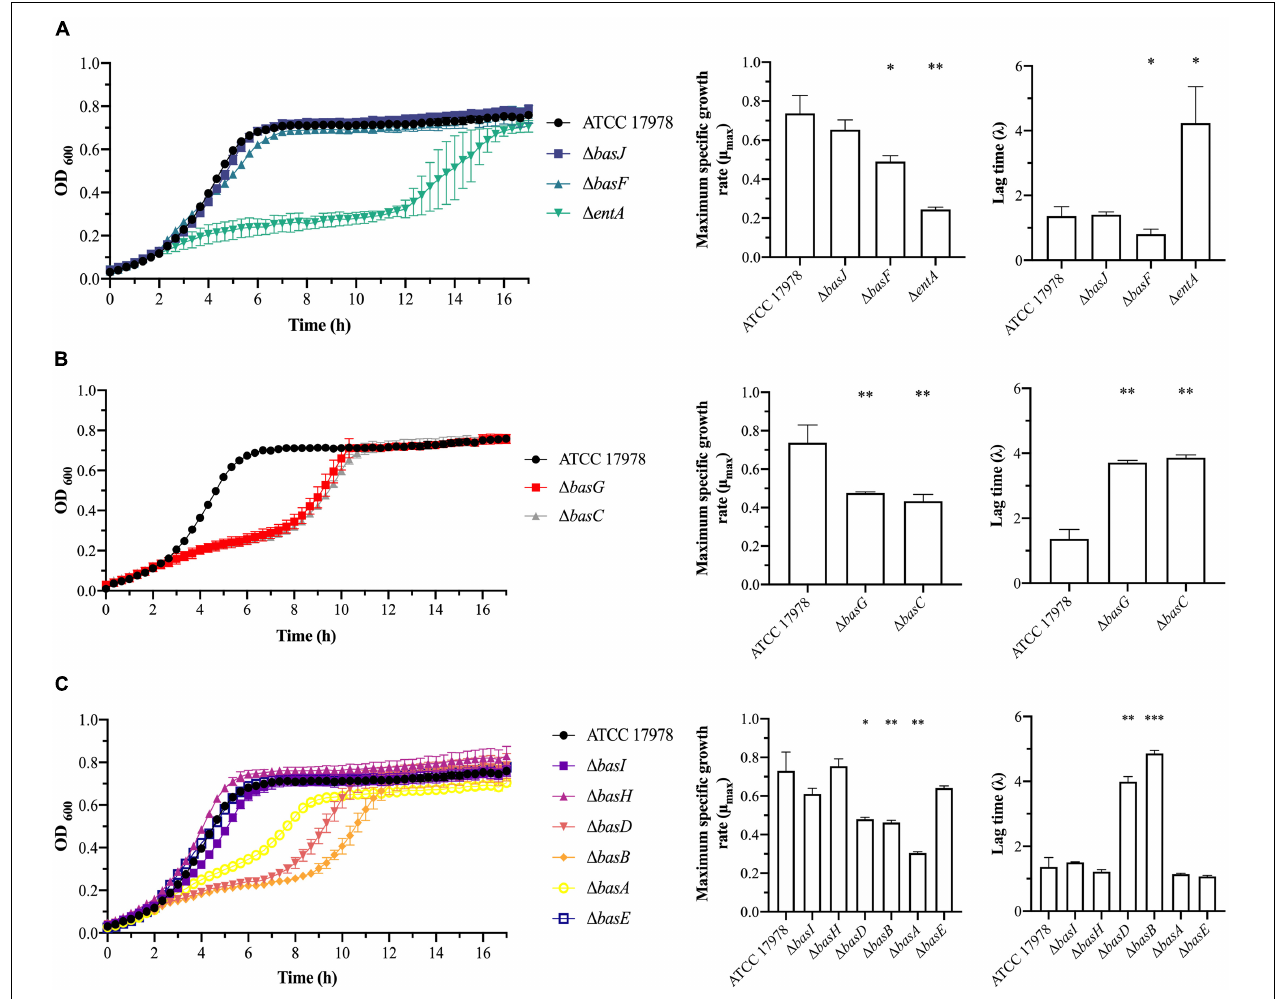
FIGURE 2 | Growth curves and growth kinetics of A. baumannii ATCC 17978 and its isogenic mutant derivative lacking (A) genes involved in the synthesis of the DHBA precursor, (B) genes involved in the synthesis of the N -hydroxyhistamine precursor and (C) genes involved in the modification and assembly of the acinetobactin precursors into the final molecule. The growth curves were performed under iron-limiting conditions. Three independent biological replicates were performed. Unpaired student t test was used for the statistical analysis of the growth kinetics ( ∗ P < 0.05; ∗∗ P < 0.01; ∗∗∗ P <